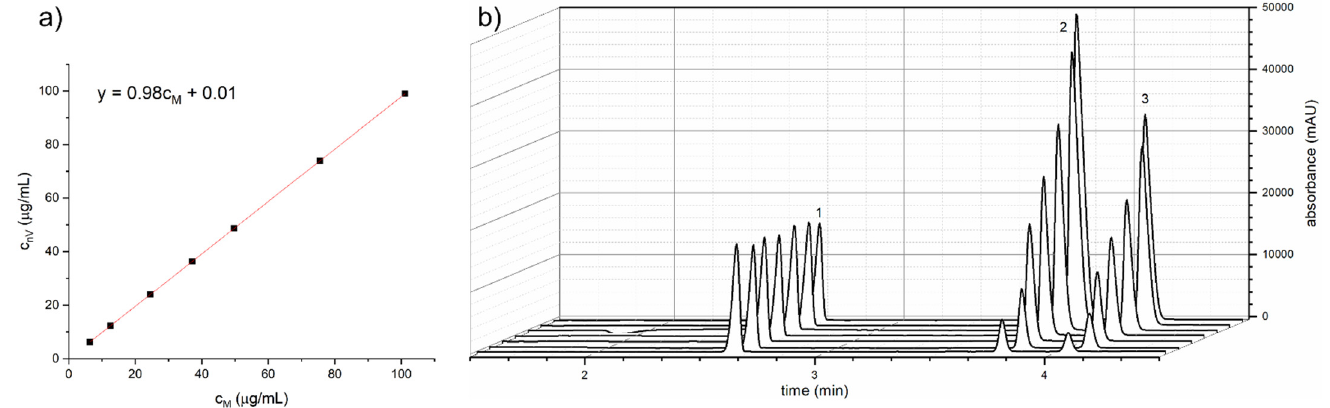
Figure 2. ( a ) Results of Deming regression for comparison concentrations obtained from the nanoVials in reverse mode (c nV ) and the manual (c M ) approach; ( b ) Electropherograms obtained by R mode in nanoVials (IS calibration method). 1: procaine (IS), 2: prilocaine, 3: bupivacaine. BGE: 103.9 mmol/L of H 3 PO 4 and 37.66 mmol/L of TRIS; CE conditions: capillary length 30.5 cm (20.5 cm to the detector), i.d. 50 μ m; applied voltage: +15 kV; hydrodynamic injection 0.5 psi for 6 s.